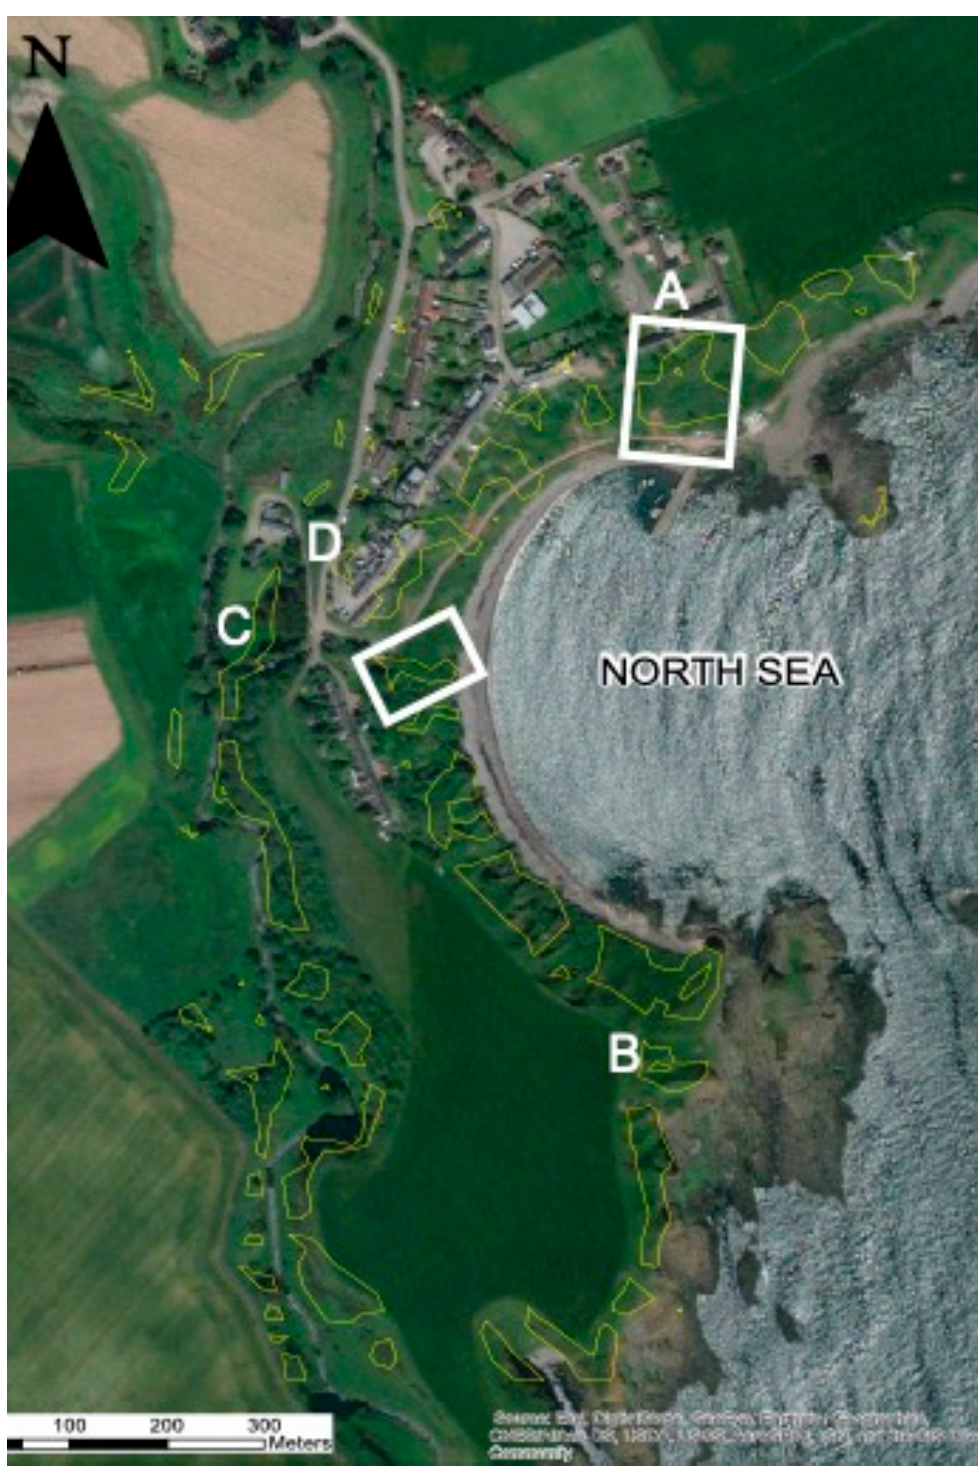
Figure 4. Landslide-prone zones detected by the proposed tool in Catterline Bay. Framed areas indicate the location of a landslip after the hazard mapping was completed (see Figure 8). Capital letters in white are related to the close-ups shown in Figure 7.